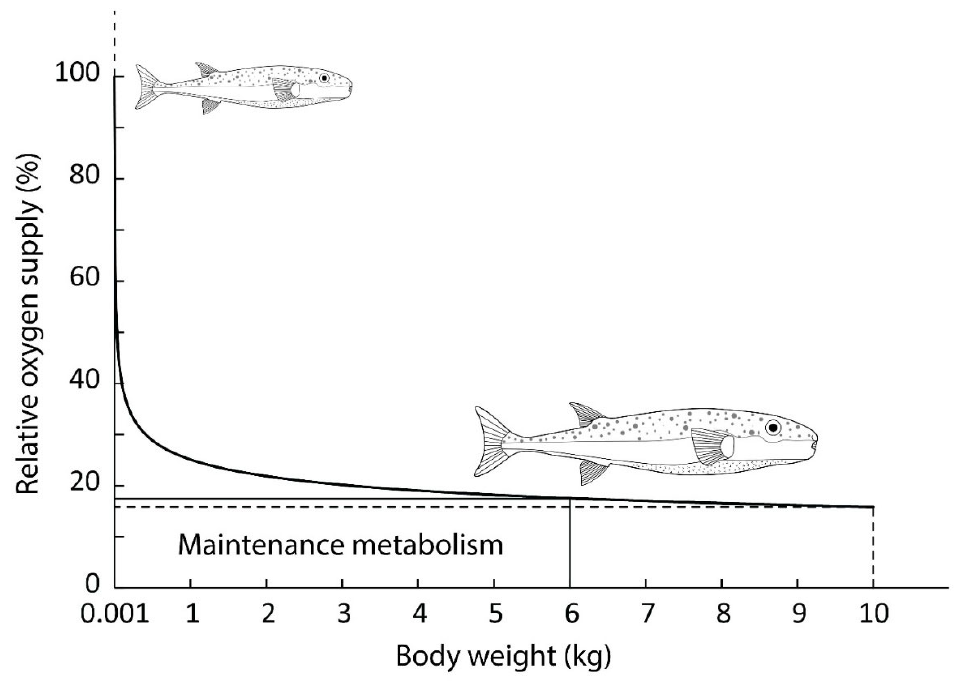
Figure 3. Weight-specific (or relative) oxygen supply of individual Lagocephalus sceleratus of 1 g to 10 kg body weight, in % of their relative oxygen supply at 1 g, given a gill surface area (S) growing according to S = a · W 0.8 . The horizontal dotted line shows that to reach 10 kg, an individual of 66 kg needs only a small reduction (10%) in its maintenance metabolism.